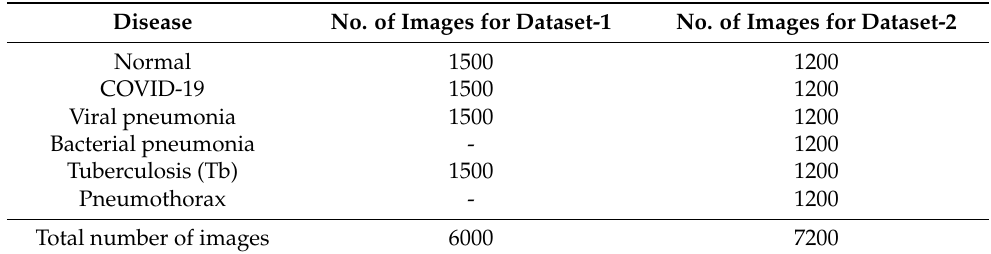
Table 2. Combined balanced datasets for three and five diseases: Dataset-1 and Dataset-2, respectively.